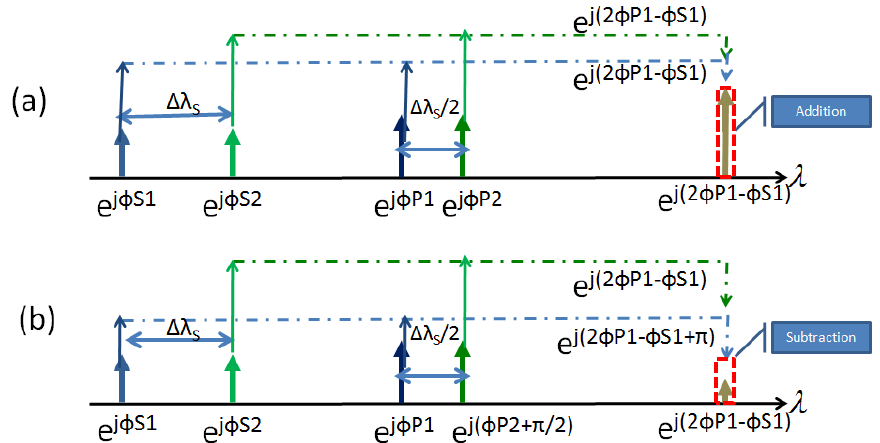
Figure 9. Principle of operation. ( a ) Selection of wavelengths based on the scheme in [23] for addition; ( b ) Illustration of the subtraction process by applying a π/2 relative phase shift to one pump